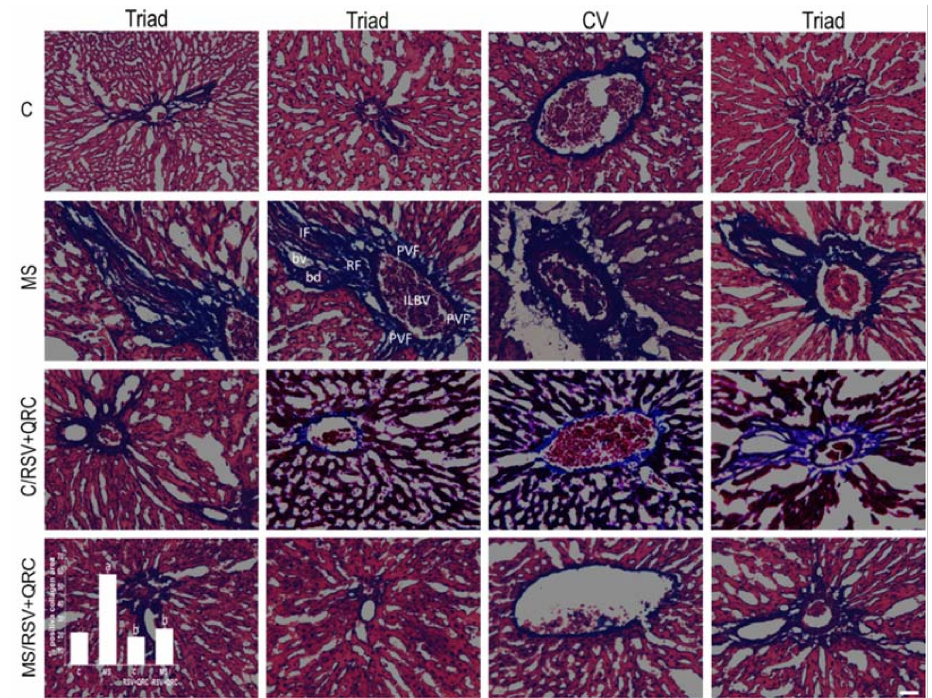
Figure 4. Resveratrol and quercetin administration attenuates liver fibrosis in the liver from MS rats. Representative images of Masson’s Trichrome staining; the triad and central vein (CV) in each condition are presented. The proportion of collagen deposits is greater in MS in the perivas- cular region (PVF), between (IF) and within the hepatocytes (RF) surrounding the vessels, both in the CV and in the triad. In the lower-left corner, the graph with the % total positive collagen area in each group is presented. a p < 0.05 vs. Control: b p < 0.01 vs. MS group. Abbreviations: C = Control, MS = metabolic syndrome; RSV + QRC = resveratrol plus quercetin, ILBV = interlob- ular vein, bd = bile duct, bv = blood vessel, PVF = perivascular fibrosis; IF = interstitial fibrosis, RF = replacement fibrosis. Bar = 50 µ